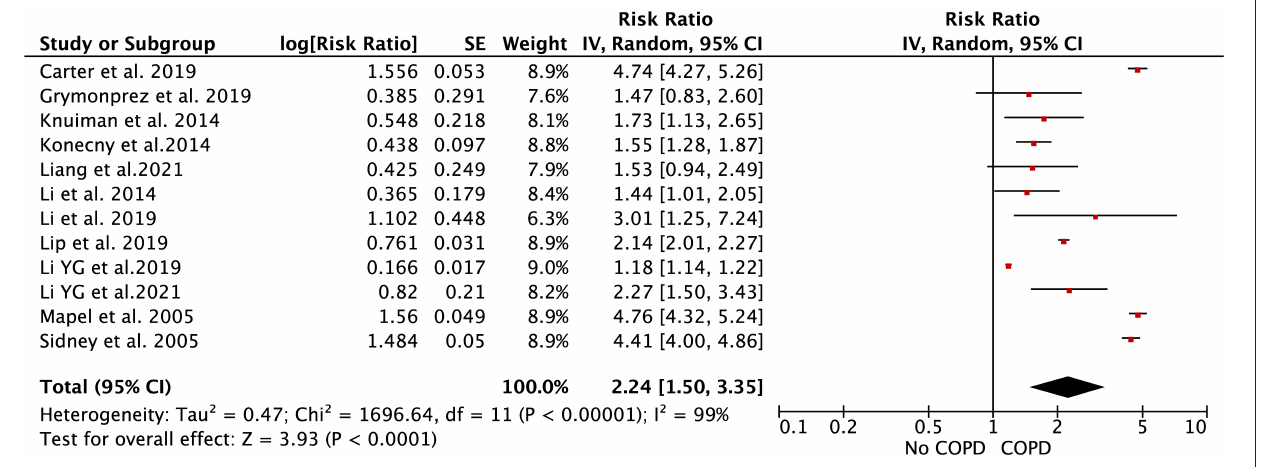
FIGURE 2 | Forest plot for the relationship between chronic obstructive pulmonary disease and the development of atrial fibrillation.